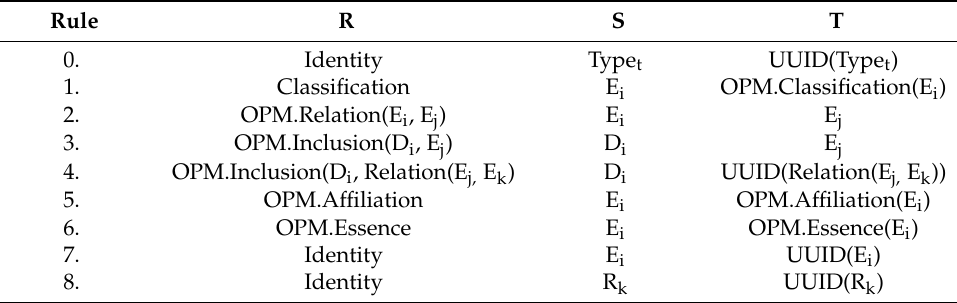
Table 5. Mapping rules from OPML to